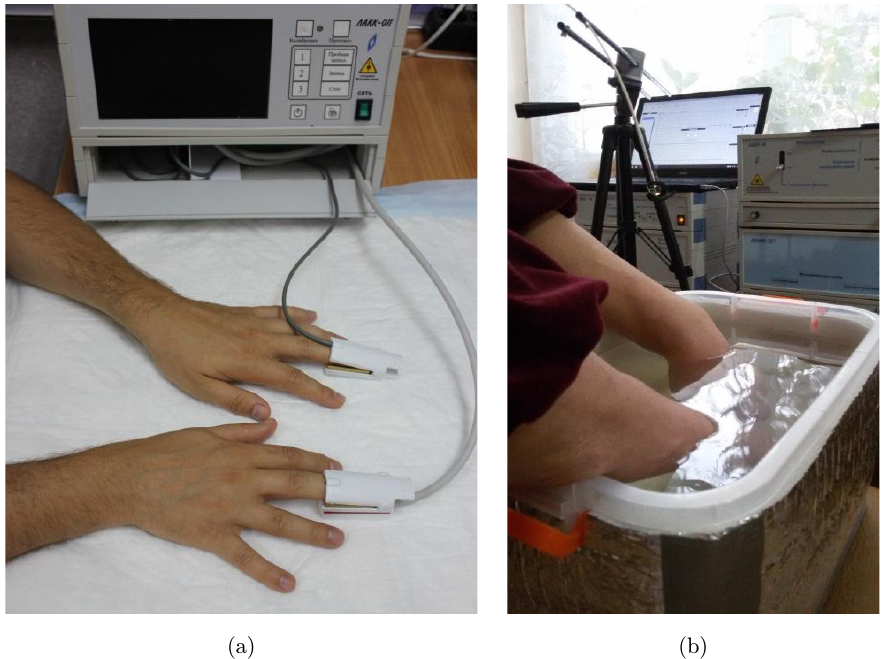
Fig. 1. The location of the optical sensors on the ¯ngers during the experimental studies on volunteers using the \LAKK-OP" (a), the experimental setup for the study on patients using the \LAKK-M"